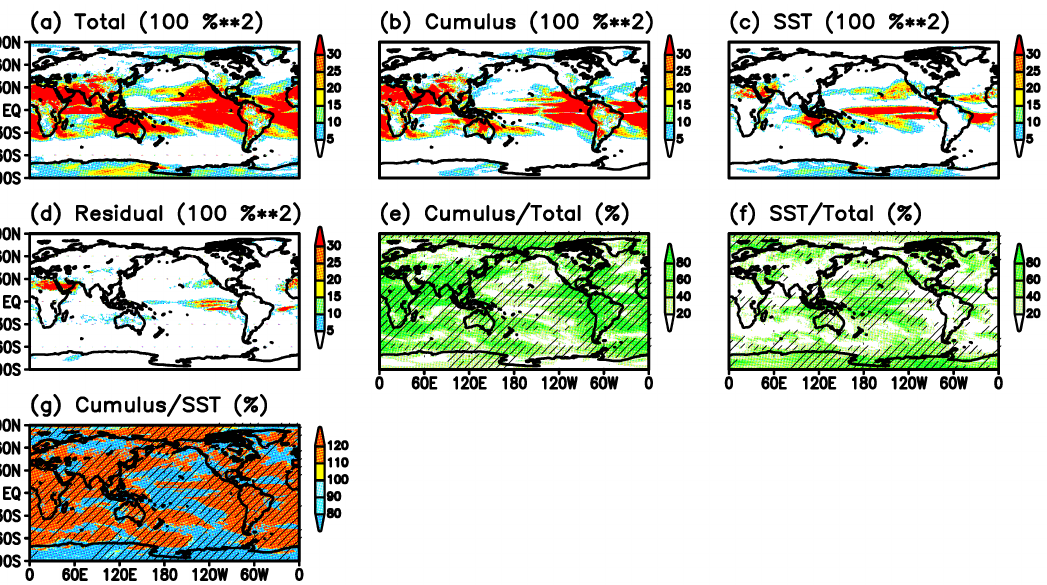
Figure 7. A two-way analysis of variance (ANOVA; [52]) applied to future annual average precipitation changes by all 12 ensemble simulations with respect to three different cumulus convection schemes and four different SST distributions (Figure 6a–d,f–i,k–n). ( a ) Total variance (100% 2 ); ( b ) variance due to convection scheme (100% 2 ); ( c ) variance due to SST (100% 2 ); ( d ) residual of variance (100% 2 ); ( e ) relative contribution of cumulus convection scheme as the ratio to the total variance (%); ( f ) relative contribution of SST as the ratio to the total variance (%); ( g ) ratio (%) of the variance by the cumulus convection scheme (b) to the variance by SST (c). Hatches show regions above the 95% significance level based on the F -test.